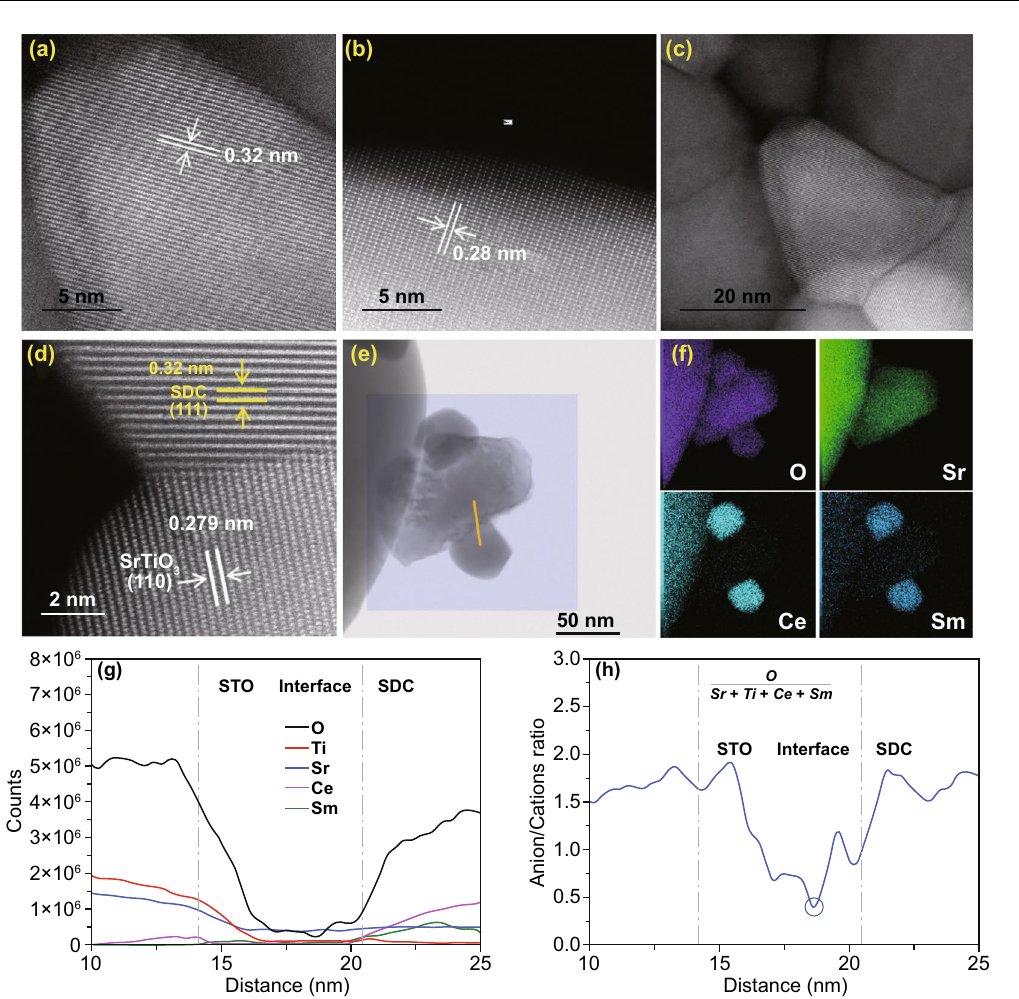
Fig. 2 HR-TEM images of a SDC grains and b STO gains with well-defined crystalline lattice. c Boundaries and interfaces between the com- pact grains. d Typical well-ordered hetero-interface between SDC and STO grains. e Survey image for EELS mapping and positions for line scan analysis. f EELS mapping of the main elements O, Sr, Ce, and Sm. g Elemental distribution analysis and h the profile of atomic ratio of O/ (Ce+Sm+Sr+Ti) across the interface of